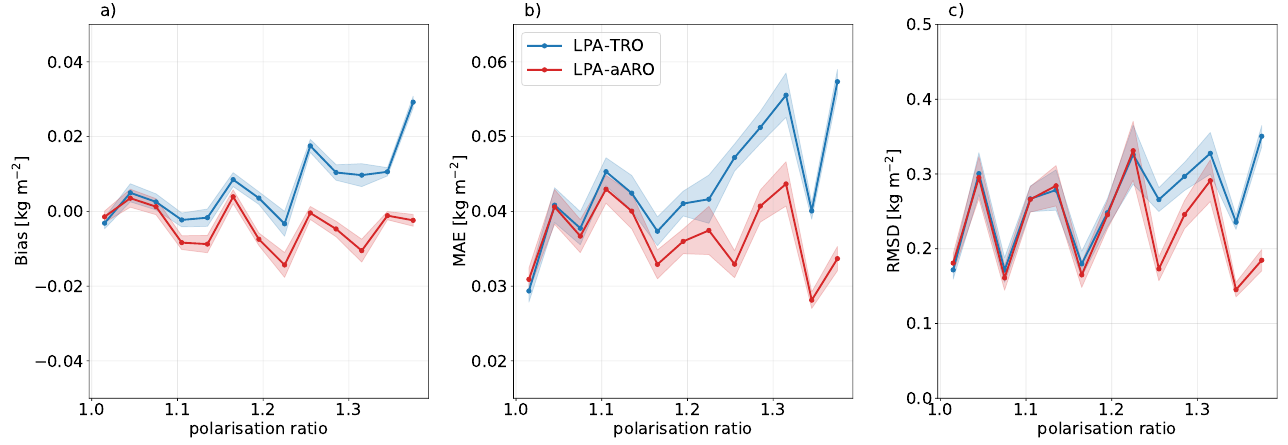
Figure 10. The statistics for ( a ) bias, ( b ) mean absolute error (MAE) and ( c ) root mean square difference (RMSD) show the accuracy of the retrieved IWPs (from test data) and were binned according to the polarisation ratio ( ρ ) into bins with a width of 0.03 each. The shaded region in all plots represents the one standard deviation of around the mean, quantified by random sampling with replacement (bootstrapping). The simulations were based on the large plate